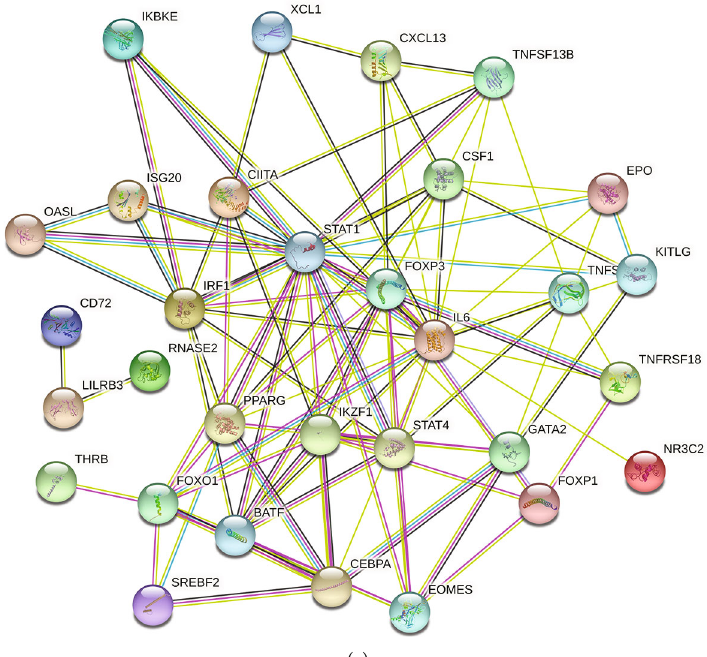
Figure 4: Analyses of prognostic-related genes and their regulatory networks and interactions with transcription factors in KIRC. (a) Forest plot based on univariable Cox proportional hazards regression analysis showing the PIGs and their hazard ratios. (b) Alluvial diagram of the PIGs and DETFs revealing their regulatory network. (c) PPI network between PIGs and